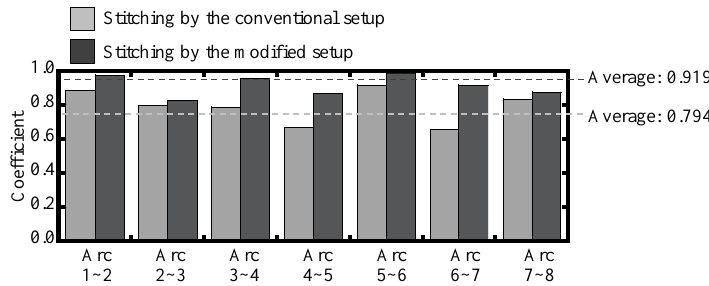
Figure 16. Cross-correlation coefficients observed in the stitching operations.